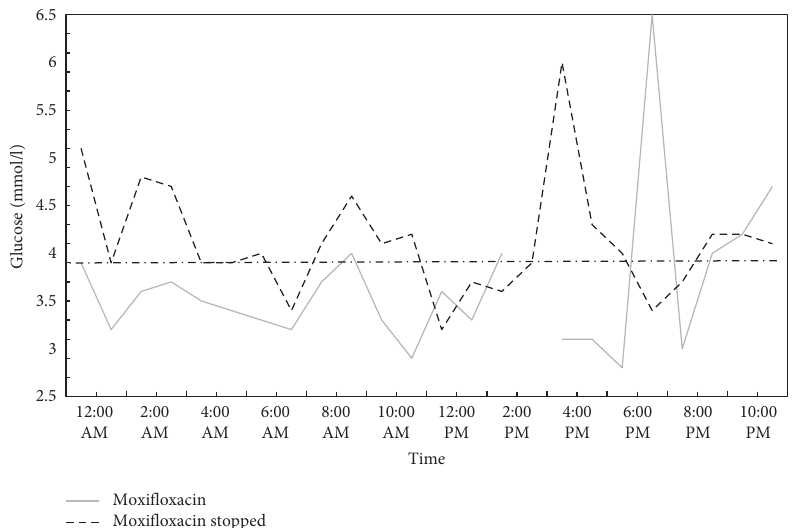
Figure 2: Hourly glucose concentration minima obtained using the sensor flash-glucose monitoring system during treatment with moxifloxacin and 4 weeks after it was stopped. The lines show the lowest glucose levels that were recorded for each hour. Each monitoring period covered 14 days. The dashed line marks the cutoff value for hypoglycemia with 3.9